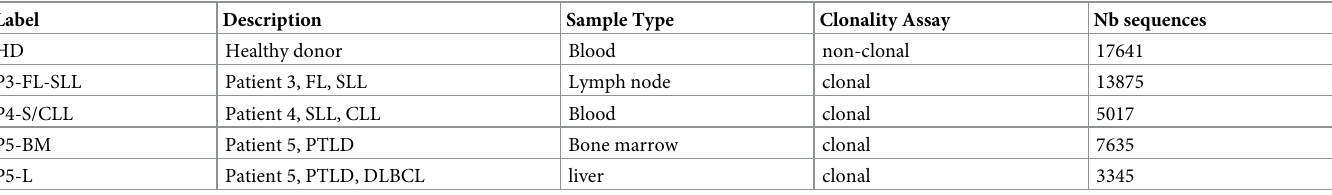
Table 3. Properties of patients and healthy donor